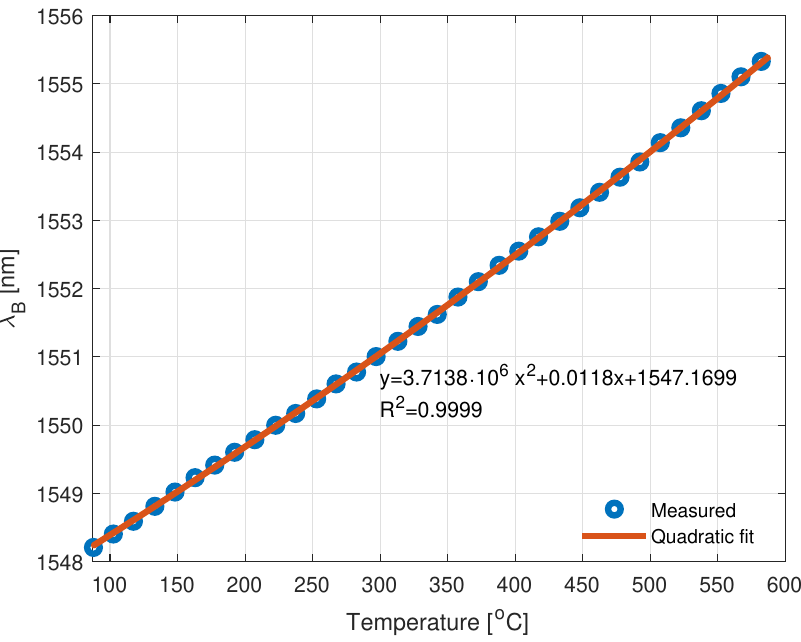
Figure 3. The dependency between FBG central wavelength and temperature induced by a hot-air soldering station. The R 2 of the quadratic fit is equal to 0.9999.